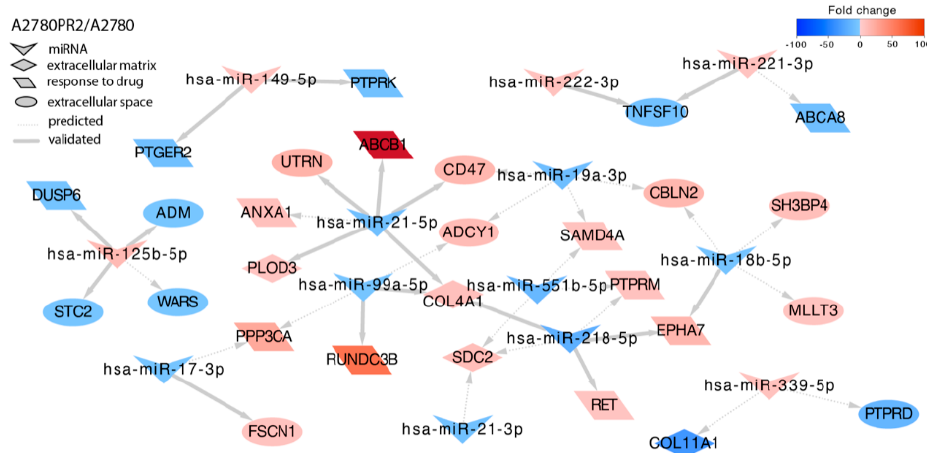
Figure 6. Regulation of selected target genes by miRNAs in the A2780PR2 cell line.